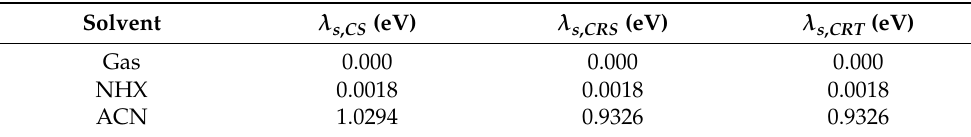
Table 9. The solvent reorganization energy calculated from the center to center distance. CRS = charge recombination to the singlet ground state, CRT = charge recombination to the triplet state, CS = charge